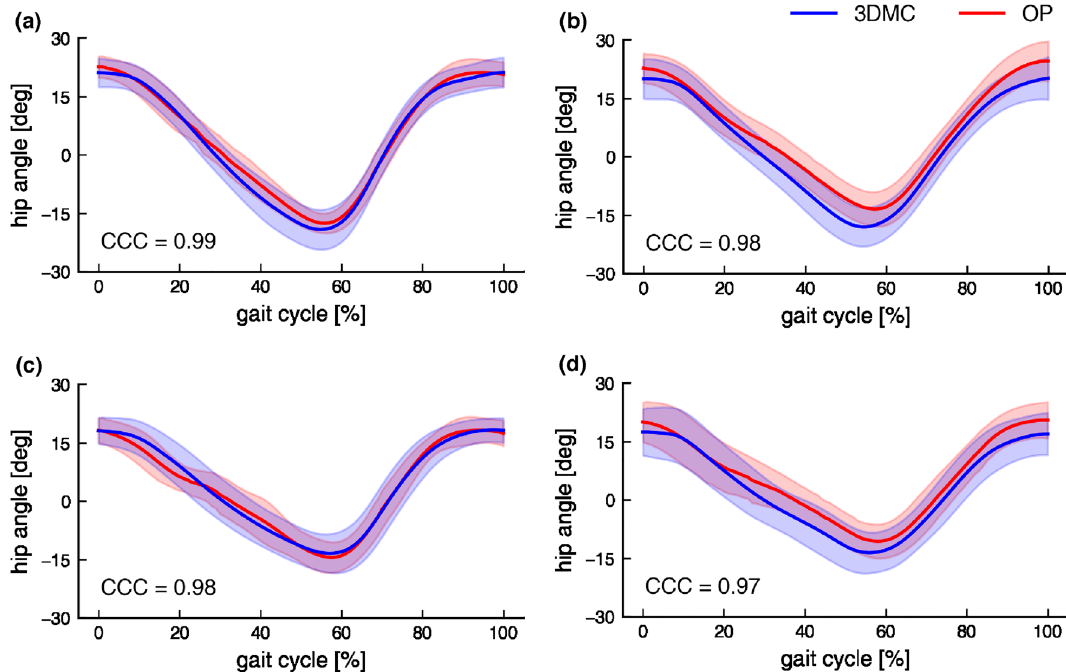
Figure 3. Hip angle by the two measurement methods. Self-selected speed with normal ( a ) and large FPA ( b ) condition. Slow speed with normal ( c ) and large FPA ( d ) condition. The shade is presented as 1 SD. Flexion is defined as positive.